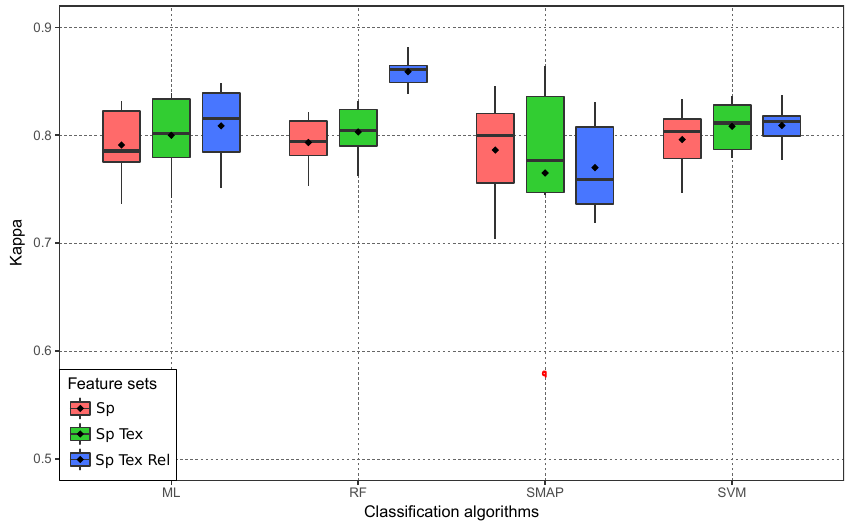
Figure 6. Distributions of kappa values obtained with the 12 combinations of algorithms and datasets in the years when four-season imagery was available (2000, 2001, 2009, 2010, 2014 and 2015). Sp: Spectral features; SpTex: Spectral and Textural features; SpTexTer: Spectral, Textural and Terrain features.